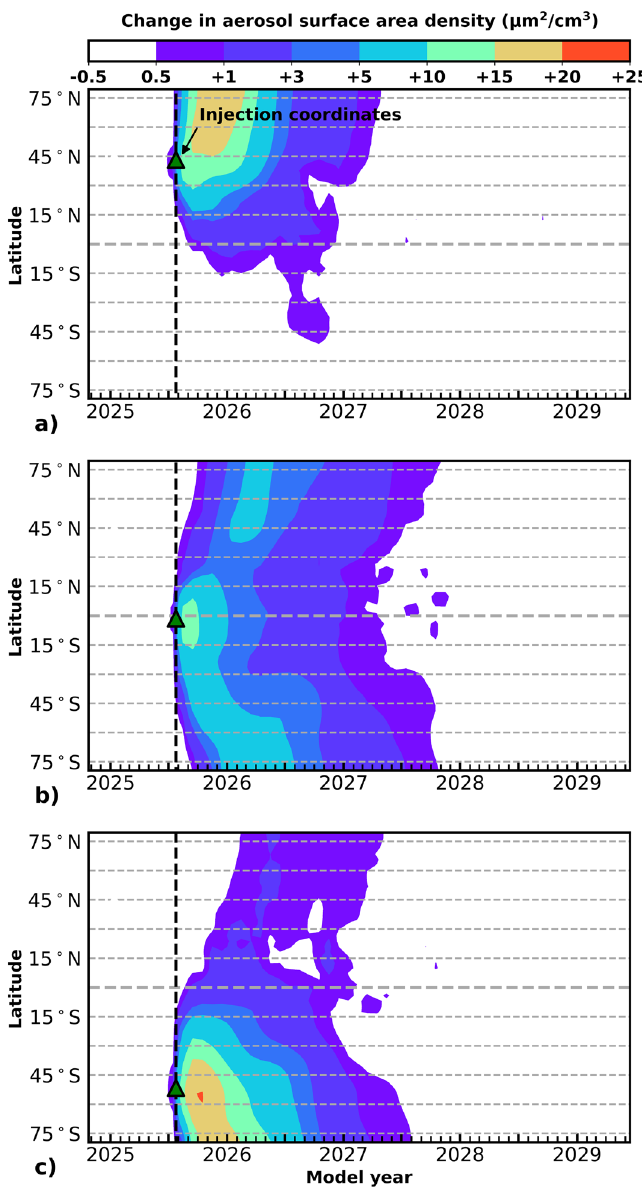
Figure 2. Aerosol surface area density (SAD) response to 5 Tg SO 2 injection (SSP3-70 July 25, 2025) as a function of latitude. In all panels, computed metrics reflect the difference in SAD between the volcanic eruption perturbation model ensemble and the baseline control model ensemble shown for a 4-year time-horizon. Total column response of aerosol SAD is indicated by the colorbar. The latitudes of eruption are: ( a ) 42 ◦ and ( c ) 50 S. Latitude and date of each SO 2 injection are indicated by a green triangle and a dashed